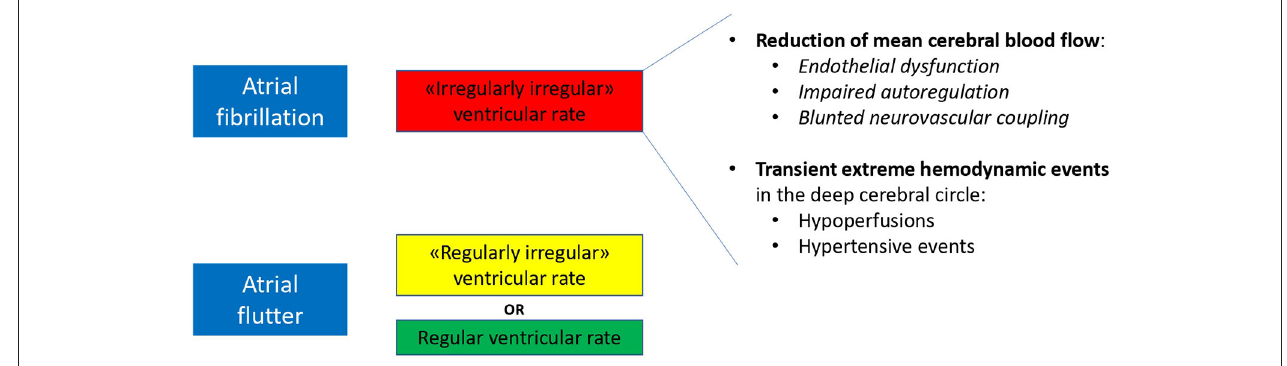
FIGURE 1 | Proposed hemodynamic determinants of a differential risk of dementia in patients with AF and AFL.